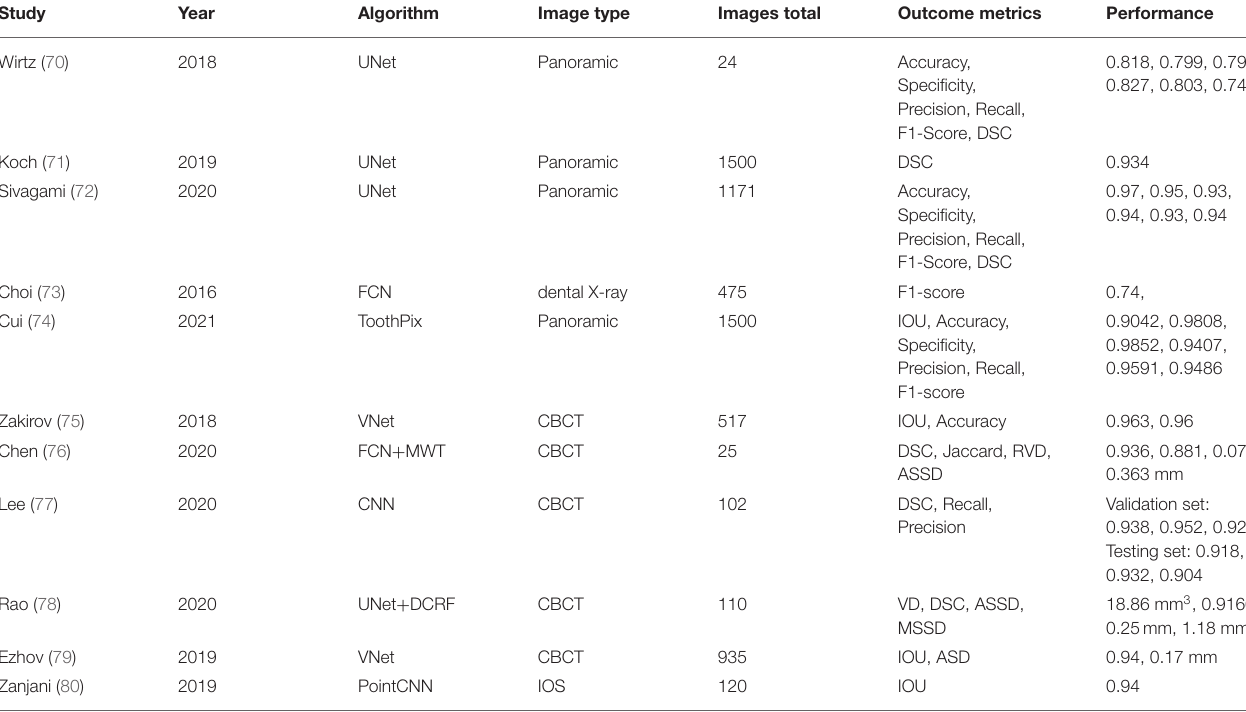
TABLE 4 | Semantic segmentation in teeth and related diseases.